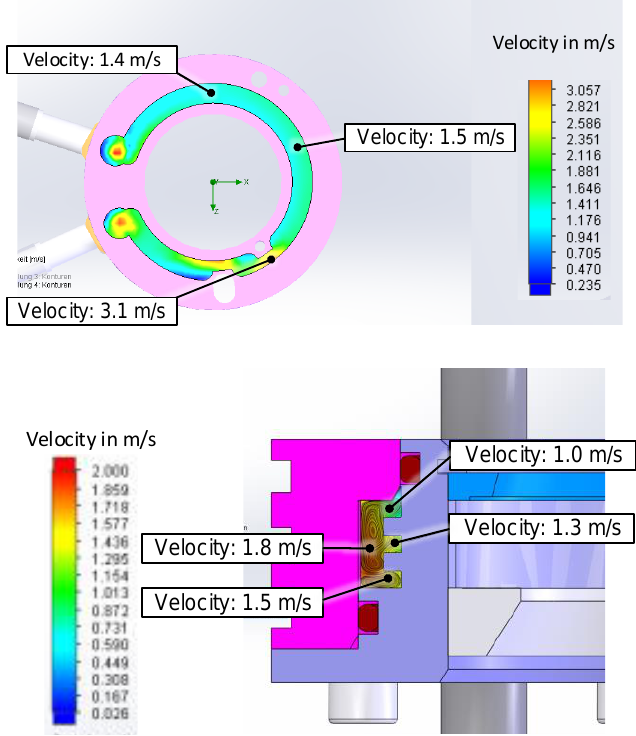
Figure 21. Thermal simulation of the bearing seat cooling channel. Simulation conducted with ANSYS fluent 2021 R1 .